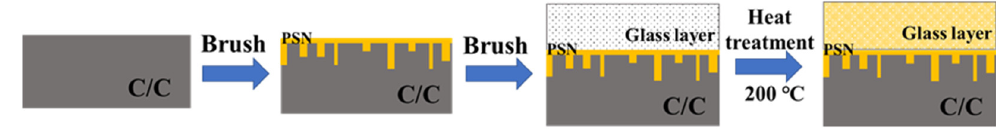
Table 1. The basic characteristics of glass powders.